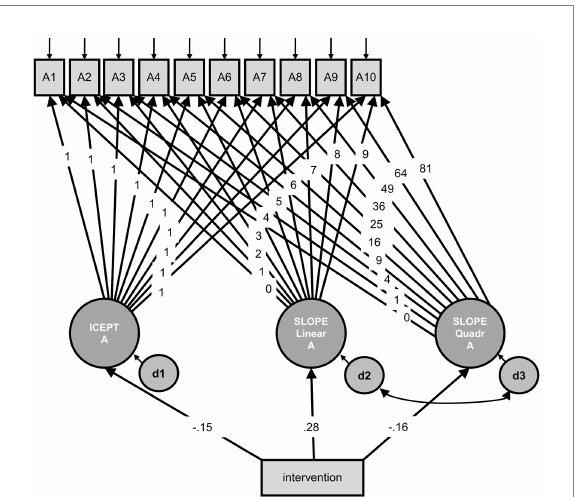
FIGURE 2 Model for automaticity with intervention as predictor variable. A1–A10 = observed automaticity, measured at 10 time points, with residuals; ICEPT A = latent intercept of automaticity, all paths to the observed automaticity variables were constrained to 1; SLOPE Linear A = latent slope of automaticity, the paths to the observed automaticity variables indicate linear growth; SLOPE Quadr A = latent slope of automaticity, the paths to the observed automaticity variables indicate quadratic growth; d1– d3 = residuals; intervention = observed predictor variable. The model revealed acceptable fit